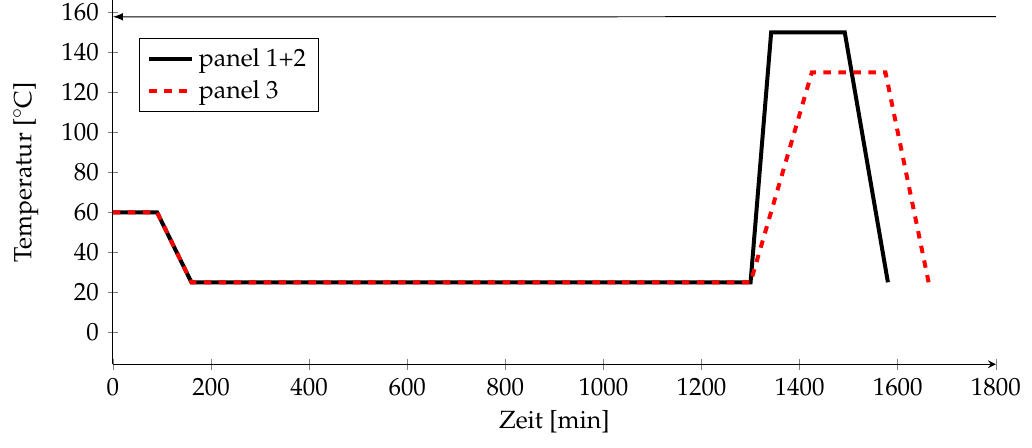
Figure 3. Curing cycles applied during the manufacturing for the three